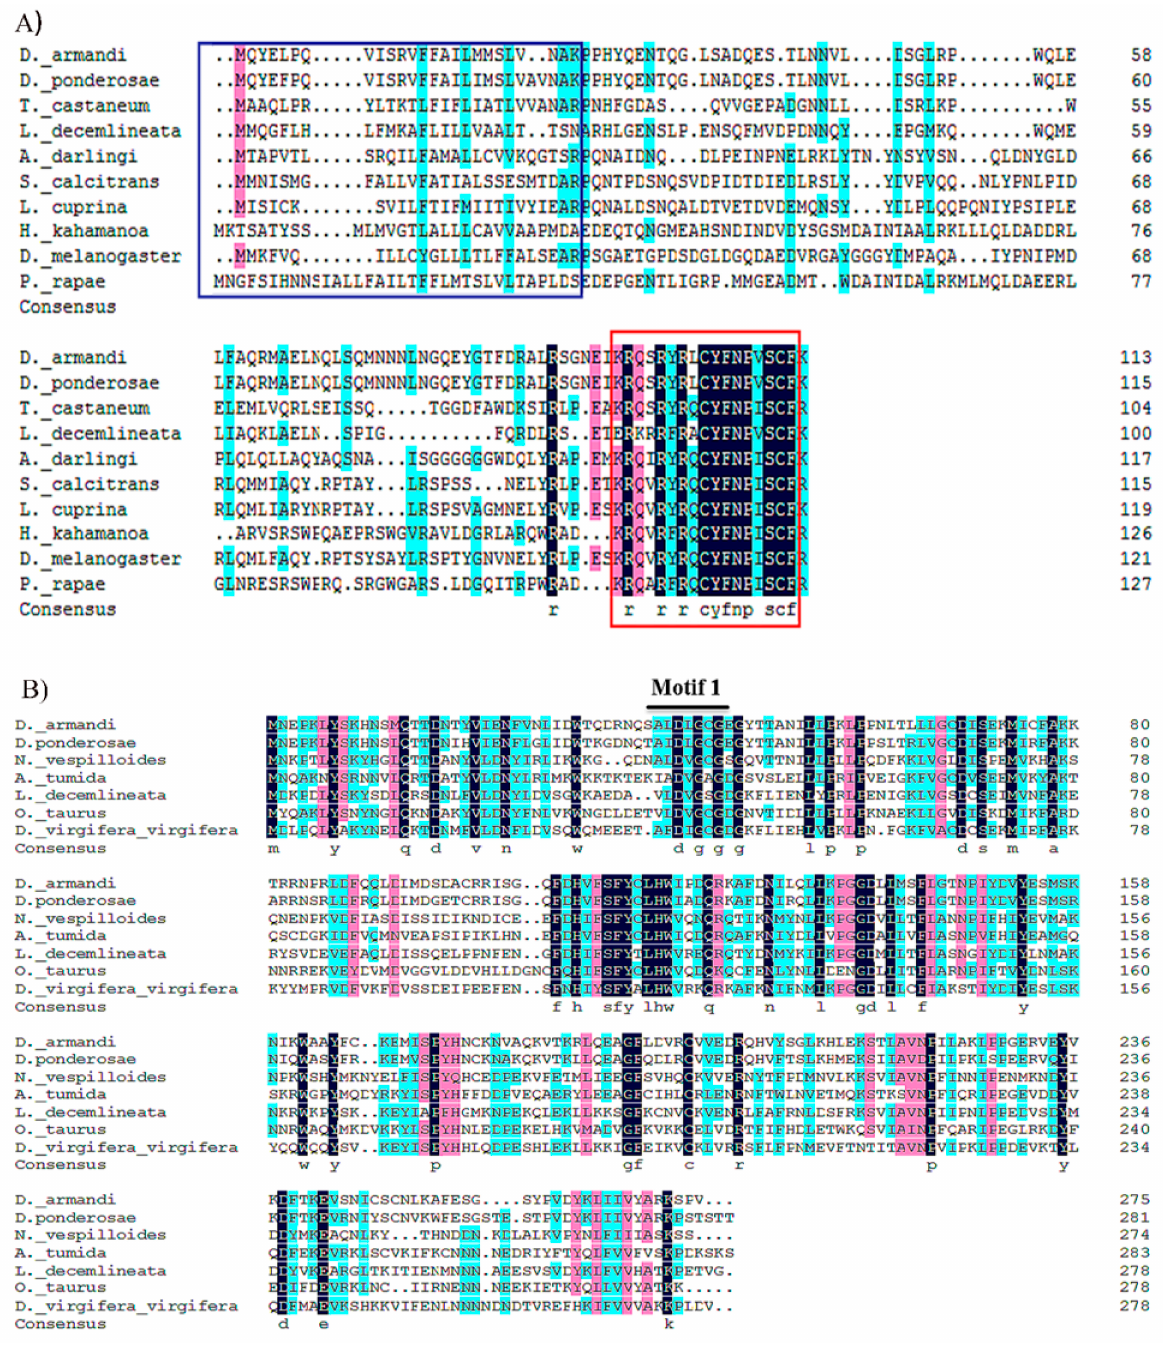
Figure 2. Structure of DaAST and DaJHAMT in D. armandi . ( A ) Alignment of putative DaAST sequence in beetle species and their consensus sequences with D. armandi sequences identified in this study. The blue color indicates similarities in the amino acid sequence. Blue frames: signal peptides at the N-termini; black: endopeptidase cleavage sites; red frames: other deduced MIP isoforms. ( B ) Alignment of DaJHAMT sequences. The conserved motif I of all SAM-dependent methyl transferases is marked with a bar above the sequences.